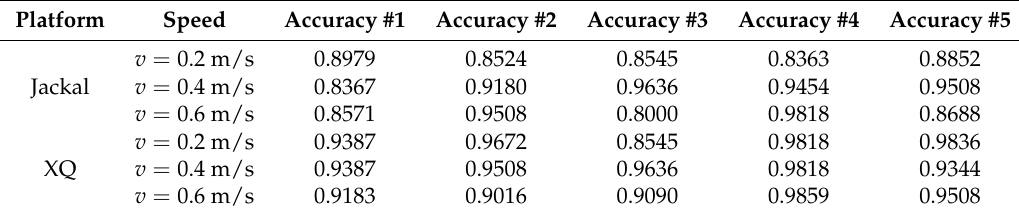
Table 4. Prediction accuracy results.